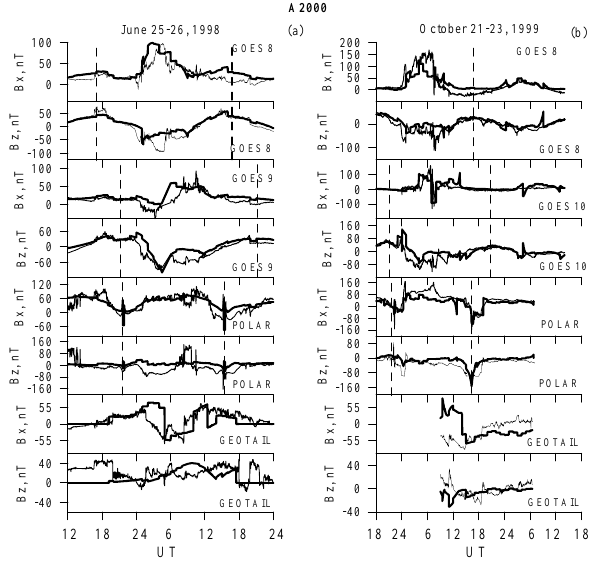
Fig. 3. Comparison of the observed B x and B z components of the external magnetic field in the GSM coordinates (thin lines) with A2000 model results (thick lines) for GOES 8 (two upper panels), GOES 9 and GOES 10 (next two panels), Polar (next two panels) and Geotail (bottom two panels) for ( a ) 25–26 June 1998 and ( b ) for 21–23 October 1999 storm events.